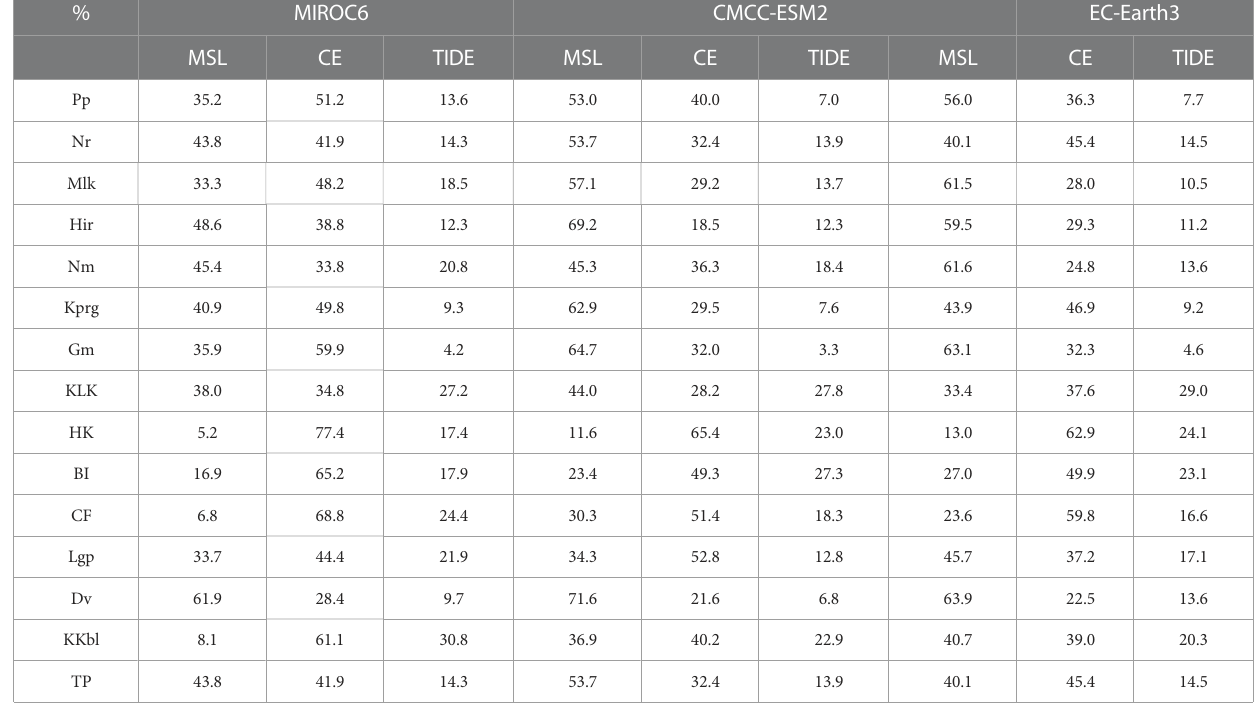
TABLE 5 The percentage of explained variance of mean sea level, extreme weather, and tide to the ESL variability based on three CMIP6 model simulations.